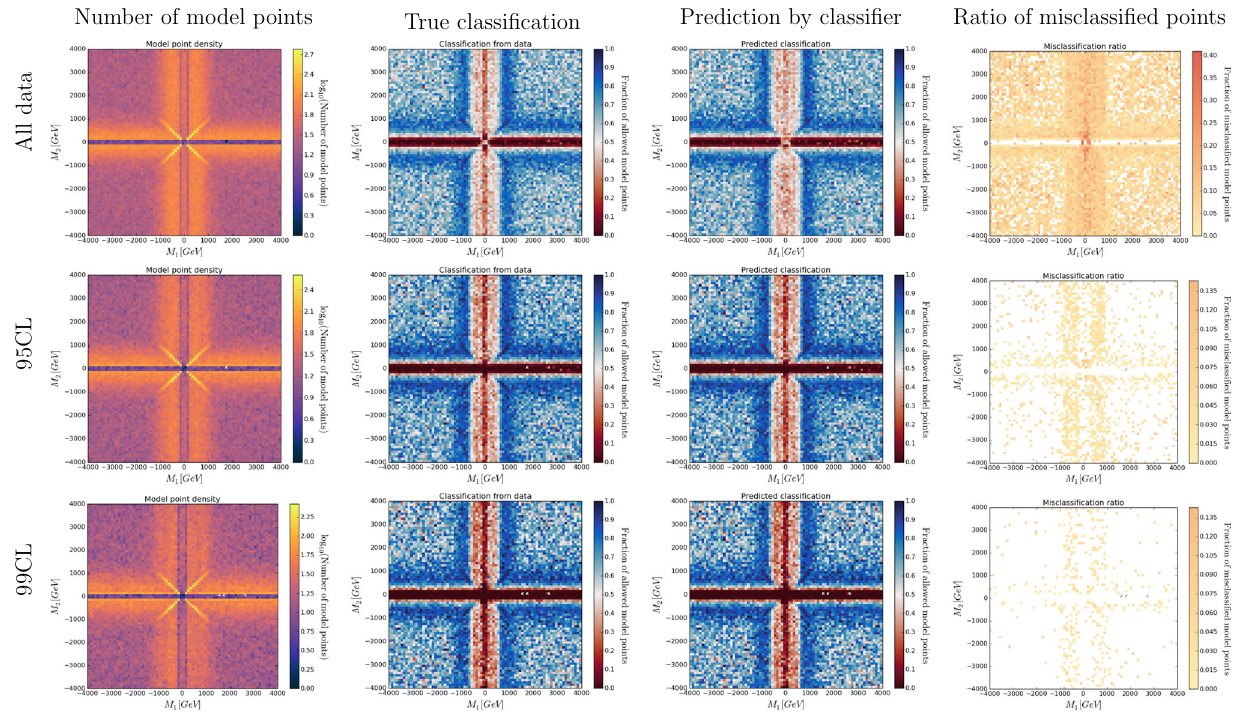
Fig. 6 Color histograms for a projection of the 19-dimensional pMSSM parameter space on the M 1 – M 2 plane. The color in the sec- ond and third column indicates the fraction of allowed data points for